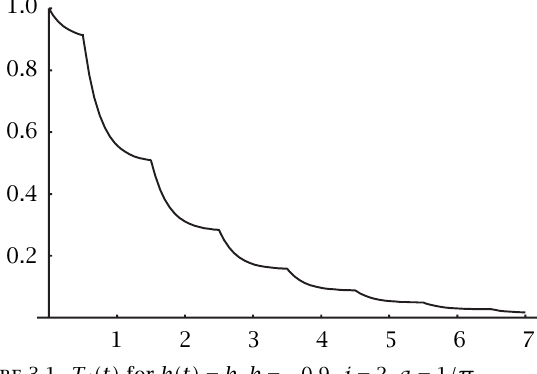
Figure 3.1 . T j (t) for b(t) = b , b = − 0 . 9, j = 2, a = 1 /π